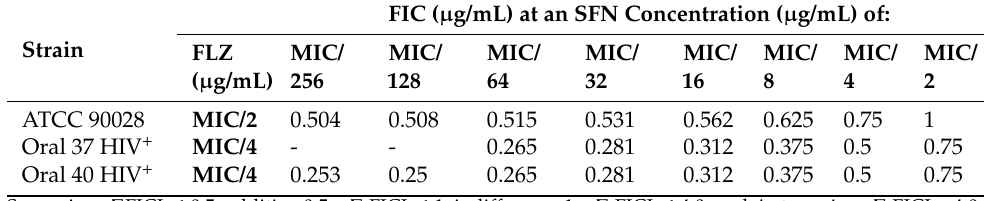
Table 4. Mean fractional inhibitory concentration indexes (FICIs) for all tested combinations between sulforaphane (SFN) and fluconazole (FLZ) against C. albicans ATCC 90028 and C. albicans clinical isolates (Oral 40 HIV + and Oral 37 HIV + ). Strains Mean FICI ( µ g/mL) Interaction C. albicans ATCC 90028 2.197 Indifferent C. albicans Oral 37 HIV + 1.412 Indifferent